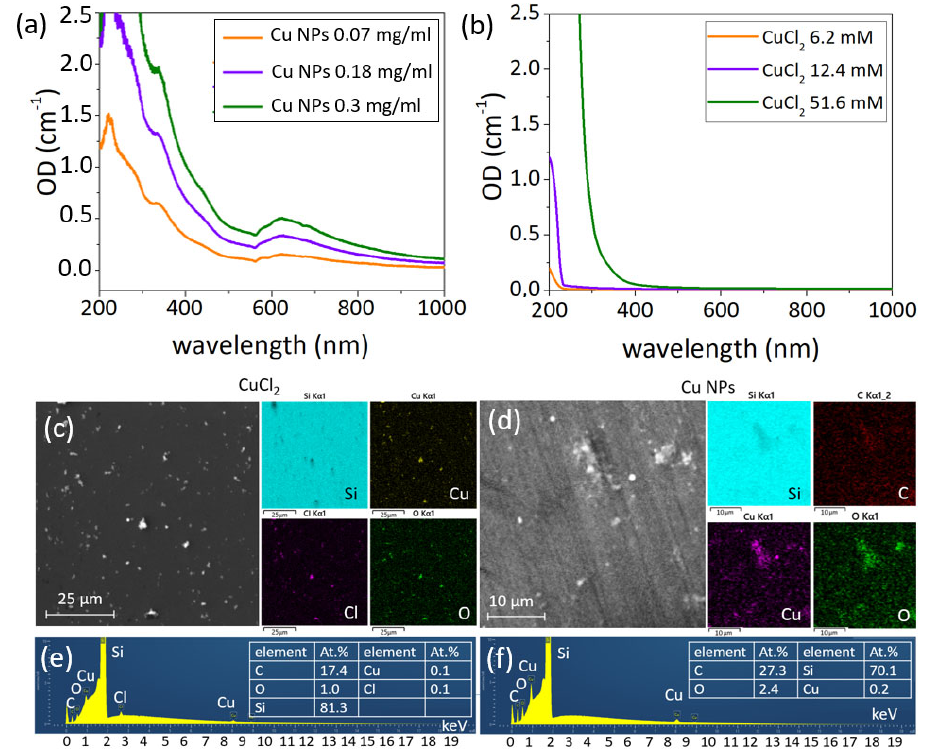
Figure 2. UV − vis spectra of ( a ) Cu NP colloid and ( b ) CuCl 2 solutions with different concentrations. SEM and EDS characterization of CuCl 2 solution ( c , e ) and Cu NP colloid ( d , f ) dried on a Si substrate. Insets on ( e , f ): tables of elements.